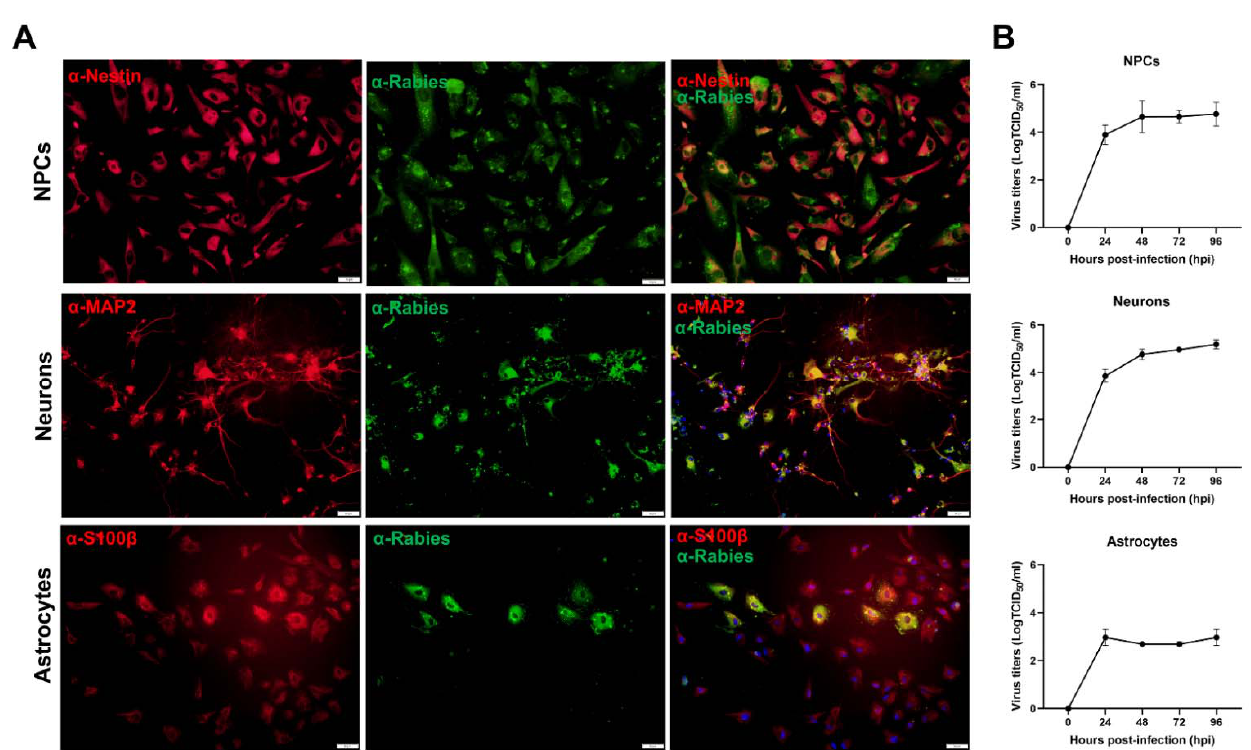
Figure 3. hiPSC-derived NPCs, neurons, and astrocytes are permissive to rabies infection. ( A ) All cell types were infected with RABV-TH at MOI of 0.5 for 72 h. The cultures were co-stained with horse α -rabies serum and mouse α -Nestin, MAP2, or S100 β antibodies for NPCs, neurons, and astrocytes, respectively. The cells were observed by fluorescence microscopy. Scale bars = 50 µm. ( B ) Cells were infected with RABV-TH at MOI of 0.5. Cell supernatants were collected daily for virus titration in BHK21 cells. Error bars represent the standard deviation of virus titers (TCID 50 / mL ) from three independent experiments.